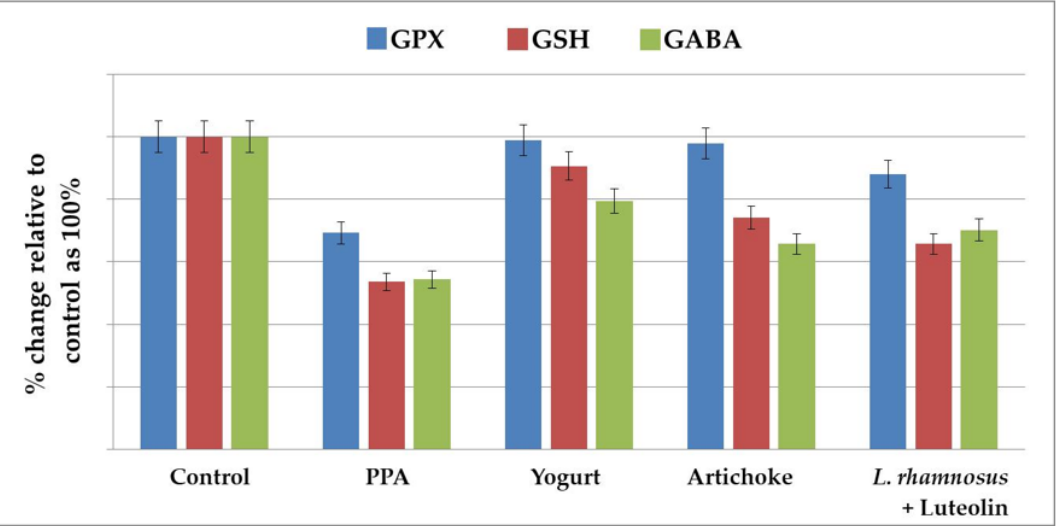
Figure 1. The percentage change in GPX, GSH, and GABA levels in the brain homogenates of an untreated PPA ‐ induced autism model and nutritionally treated groups of yogurt, artichokes, and combined L. rhamnosus + luteolin relative to the control, presented as 100%.